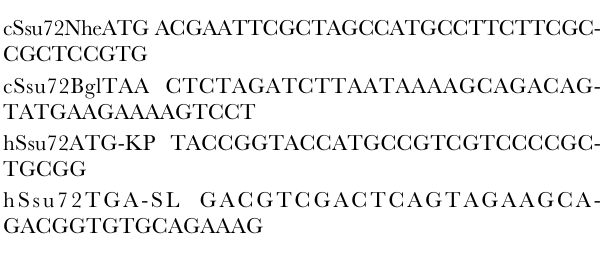
Figure S1 The levels of total snRNAs and mRNA are not significantly changed by Ssu72 depletion. (A) The expres- sion levels of chicken U2 snRNA, U4 snRNA, and GAPDH in DT40 P3 ( 2 / 2 ) cells treated with Dox for the indicated days were measured by RT-qPCR analysis. The relative expression levels were normalized to those of 0 day. Error bars indicate standard deviation. (B) The expression levels of chicken U4, U13, and GAPDH in DT40 P3 ( 2 / 2 ) cells treated with Dox for the indicated days were measured by Northern blot analysis probed with the 32 P-labeled specific cDNA fragments. Figure S2 The levels of total histone mRNAs are not dramatically changed by Ssu72 depletion. The expression levels of chicken H4 and H3 histone mRNAs in DT40 P3 ( 2 / 2 ) cells treated with Dox for the indicated days were measured by RT-qPCR analysis. The relative expression levels were normalized to those of 0 day. Error bars indicate standard